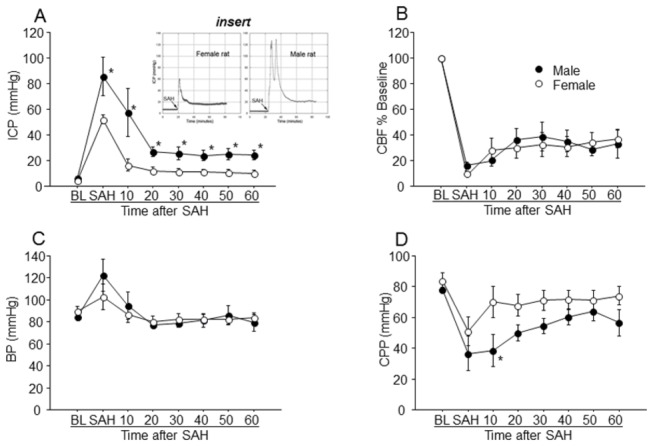
Gender differences in early physiology of SAH.ICP, CBF, and BP were measured in the real time from 20 minutes before to 60 minutes after SAH induction. CPP was calculated (BP-ICP). In panel A note that ICP peaked and declined to greater values in males than in females after SAH. Inserts in panel A shows ICP recordings from a single male and a single female rat; note multiple ICP peaks in the male and not in female. Panels B and C show similar cross-gender differences in CBF and BP post SAH. In panel D note different profiles of CPP changes in males and females after SAH. Data are mean ± sem from 10 animals per gender. * significantly difference from females, p <0.01).